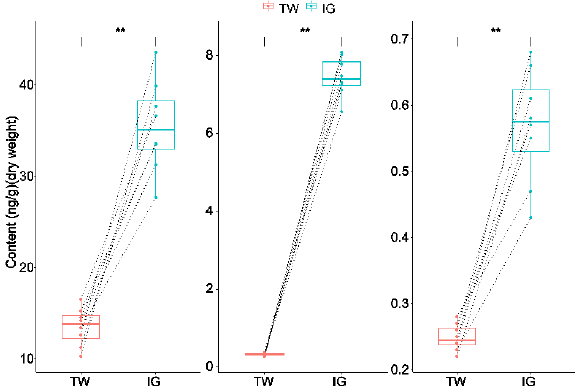
Figure 1. The contents of IAA, tZR and iP in Lithosaphonecrus arcoverticus galls and the galled twigs of Lithocarpus glaber . IAA, tZR and iP represent indoleacetic acid, trans-zeatin riboside and isopentenyladenine, respectively. IG and TW indicate L. arcoverticus galls and the galled twigs of L. glaber , respectively. Dotted lines indicate galled twigs and paired L. arcoverticus galls. The top and bottom horizontal lines of the boxplot indicate 25th and 75th percentiles, respectively. The lines within the box indicate median values. ** indicates a significant difference ( p < 0.01).